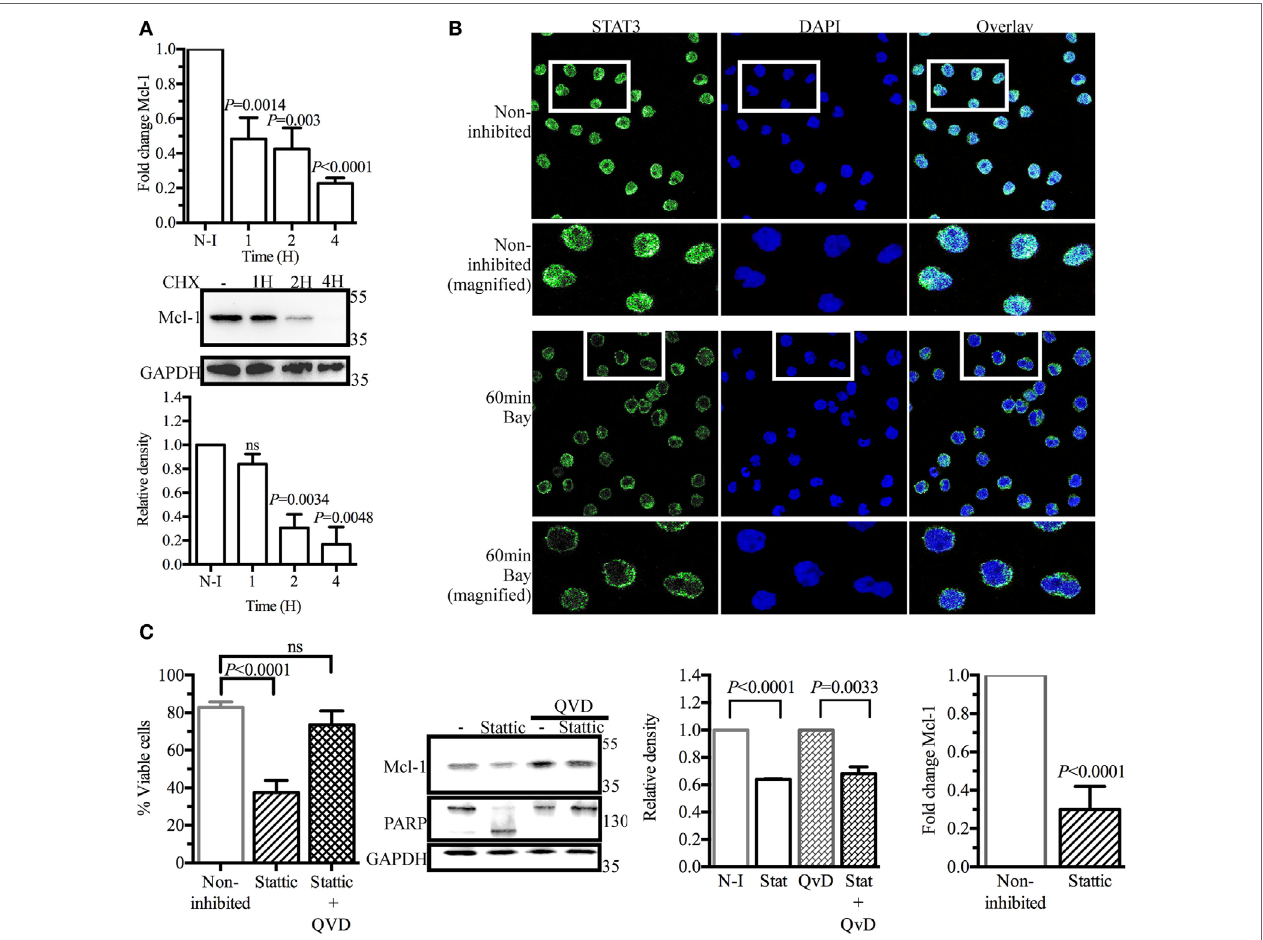
FigUre 3 | Signal transducer and activator of transcription 3 (STAT3) as a potential regulator of myeloid cell leukemia-1 (Mcl-1) gene transcription in BL41 cells (Burkitt’s lymphoma cells) upon spleen tyrosine kinase inhibition. (a) BL41 cells were treated with BAY61-3606 (5 µM) for 1, 2, and 4 h and expression of the Mcl-1 gene was assessed by RT-qPCR. Mean values are shown ( ± SEM, n = 5), and significant P -values are indicated for comparisons with cells not treated with BAY61-3606. BL41 cells were treated with cycloheximide (10 µM) for 1, 2, and 4 h and Mcl-1 protein levels were determined by western blotting, with quantification by protein densitometry and normalization against GAPDH levels. Mean values are shown ( ± SEM, n = 3), and significant P -values are indicated for comparisons with cells not treated with BAY61-3606. (B) BL41 cells were treated with BAY61-3606 (5 µM; 60 min), and the cellular location of STAT3 was determined by immunofluorescence analyses. Images were obtained with a Leica confocal microscope equipped with a 63 × objective. (c) The viability of BL41 cells was determined by flow cytometry analysis in cells treated with the STAT3 inhibitor Stattic (5 µM; 16 h) in the presence or absence of Q-VD-Oph (10 µM). Apoptotic cells were identified on the basis of their size and granularity, as assessed by forward and side light scattering. The data shown are mean values ( ± SEM, n = 6). Mcl-1 protein levels were assessed by western blotting after treatment with Stattic (5 µM; 4 h) and Q-VD-Oph (10 µM); Mcl-1 levels were quantified by protein densitometry and normalized against GAPDH levels. The data shown are mean values ( ± SEM, n = 3). Q-VD-Oph efficiency was determined by western blotting to analyze PARP cleavage (4 h) and cell death inhibition (16 h). Mean values are shown ( ± SEM, n = 6). Mcl-1 gene expression levels were determined by RT-qPCR. Mean values are shown ( ± SEM, n = 4), and significant P -values are shown for comparisons with cells not treated with BAY61-3606. CHX, cycloheximide; N-I, non-inhibited; Bay, BAY61-3606; QVD, Q-VD-Oph; ns, not